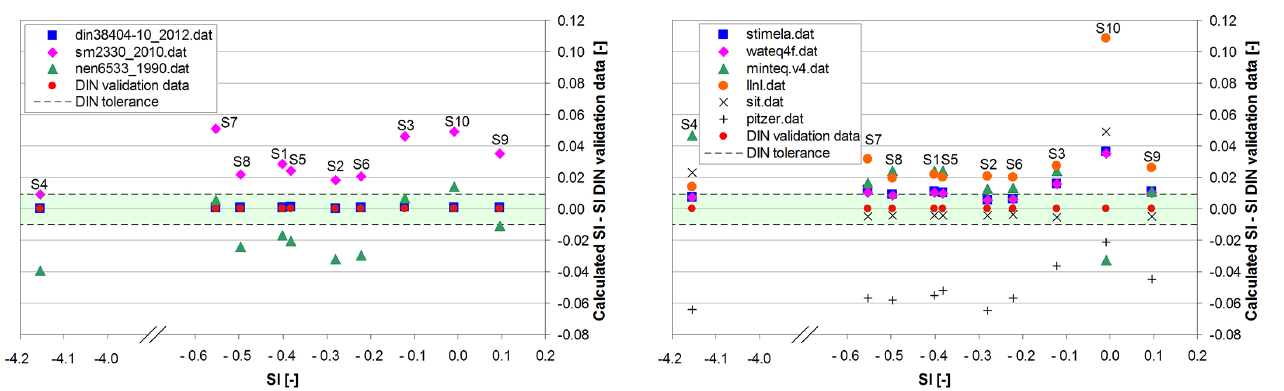
Figure 2. Deviations of the SIs calculated in PHREEQC according to the DIN, SM and NEN standards, from the SIs given in the DIN validation data set for the 10 water quality samples S1 to S10 (see Table 5).